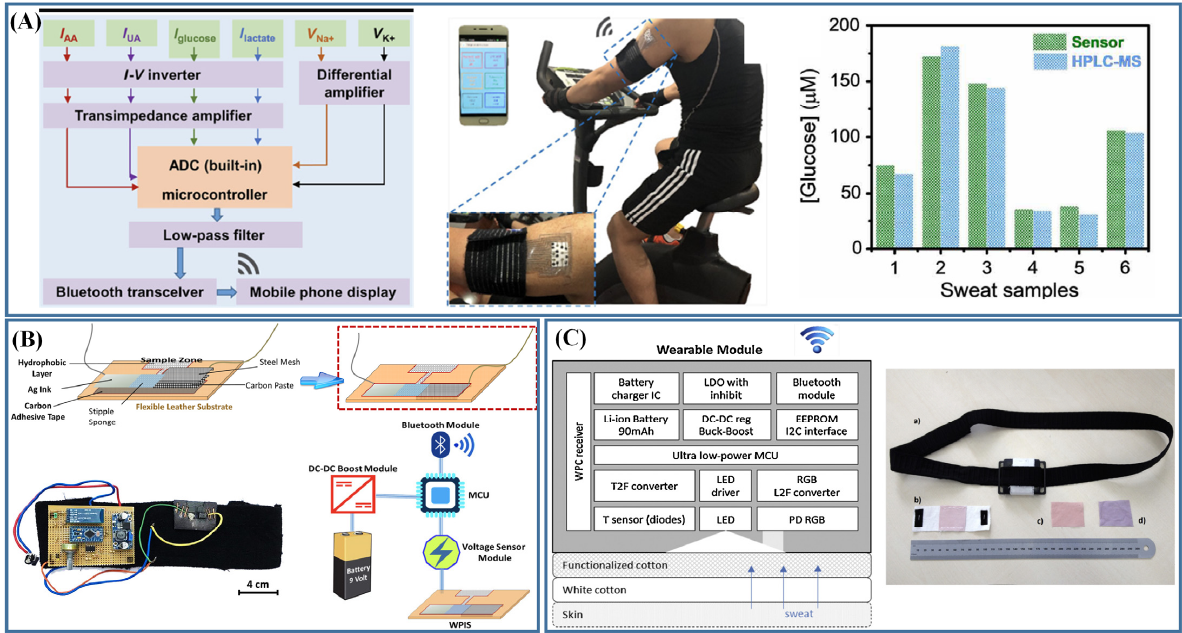
Figure 3. Sweat sensors integrated with communication technologies. ( A ) Sweat sensor based on electrochemical detection was applied for real-time multiple analysis of sweat [71]; ( B ) Sweat sensors based on potentiometric detection and signal readout circuits were embedded into a wearable sweat headband (Reprinted with permission from Ref. [87]. Copyright 2022, copyright American Chemical Society); ( C ) The main components of wearable system based on colorimetric detection (Reprinted with permission from Ref. [88]. Copyright 2016, copyright Elsevier).